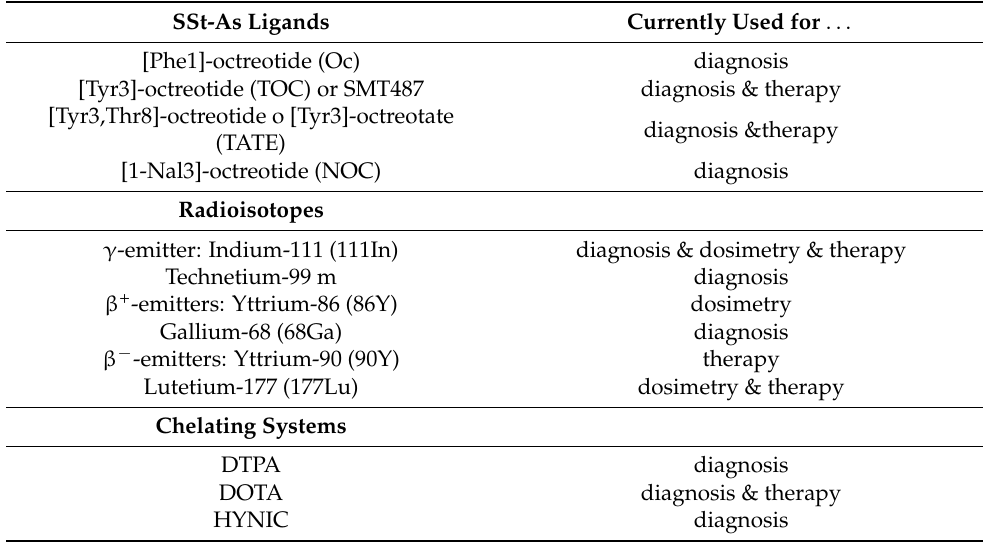
Table 1. Ligands, radioisotopes, and chelating systems currently most available for clinical PRRT. The table is functional to our objectives but does not represent the panorama of radiopharmaceu- ticals developed for diagnostic or therapeutic use and currently subjected to preclinical or clinical studies. (DTPA: diethylenetriamine-pentaacetic acid; DOTA: 1,4,7,10-tetraaza-cyclododecane-1,4,7,10- tetraacetic